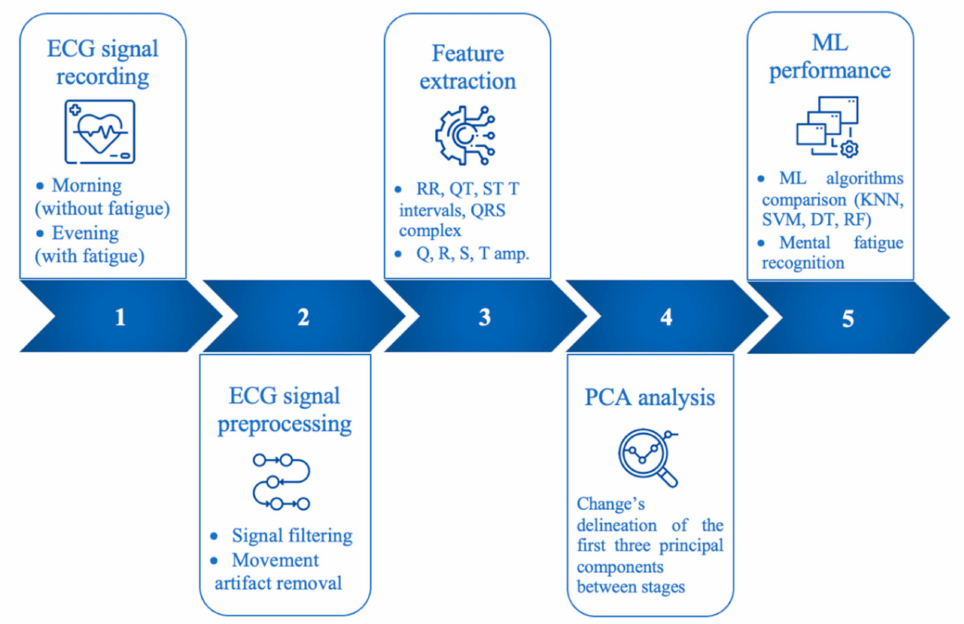
Figure 1. Proposed framework for mental fatigue detection.